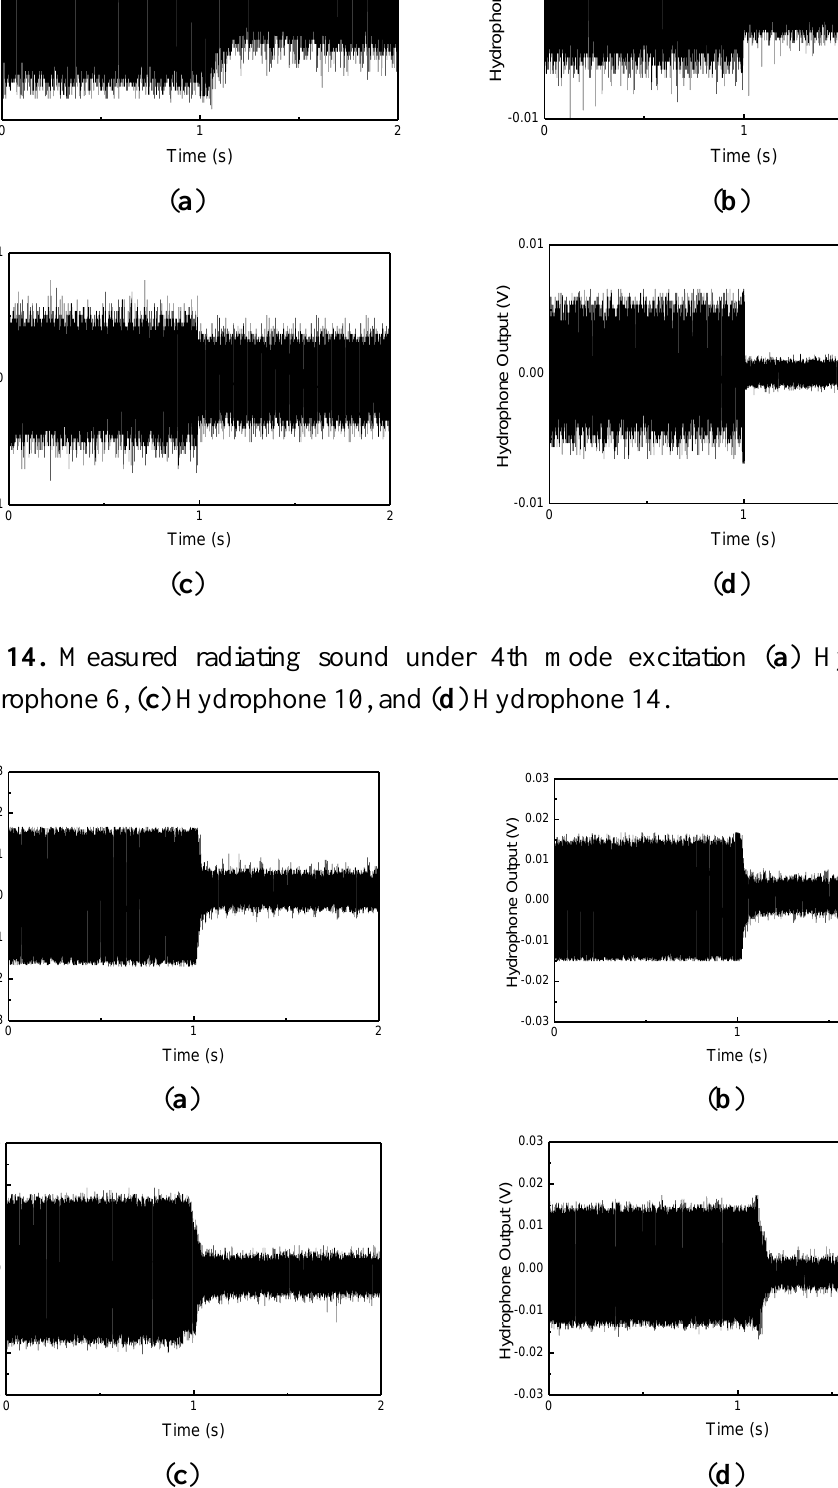
Figure 13. Measured radiating sound under 3rd mode excitation. ( a ) Hydrophone 2, ( b ) Hydrophone 6, ( c ) Hydrophone 10, and ( d ) Hydrophone 14.